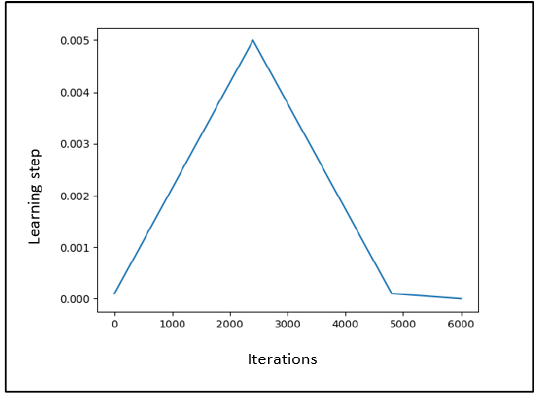
Figure 1. An example model that learns with fixed learning rate.